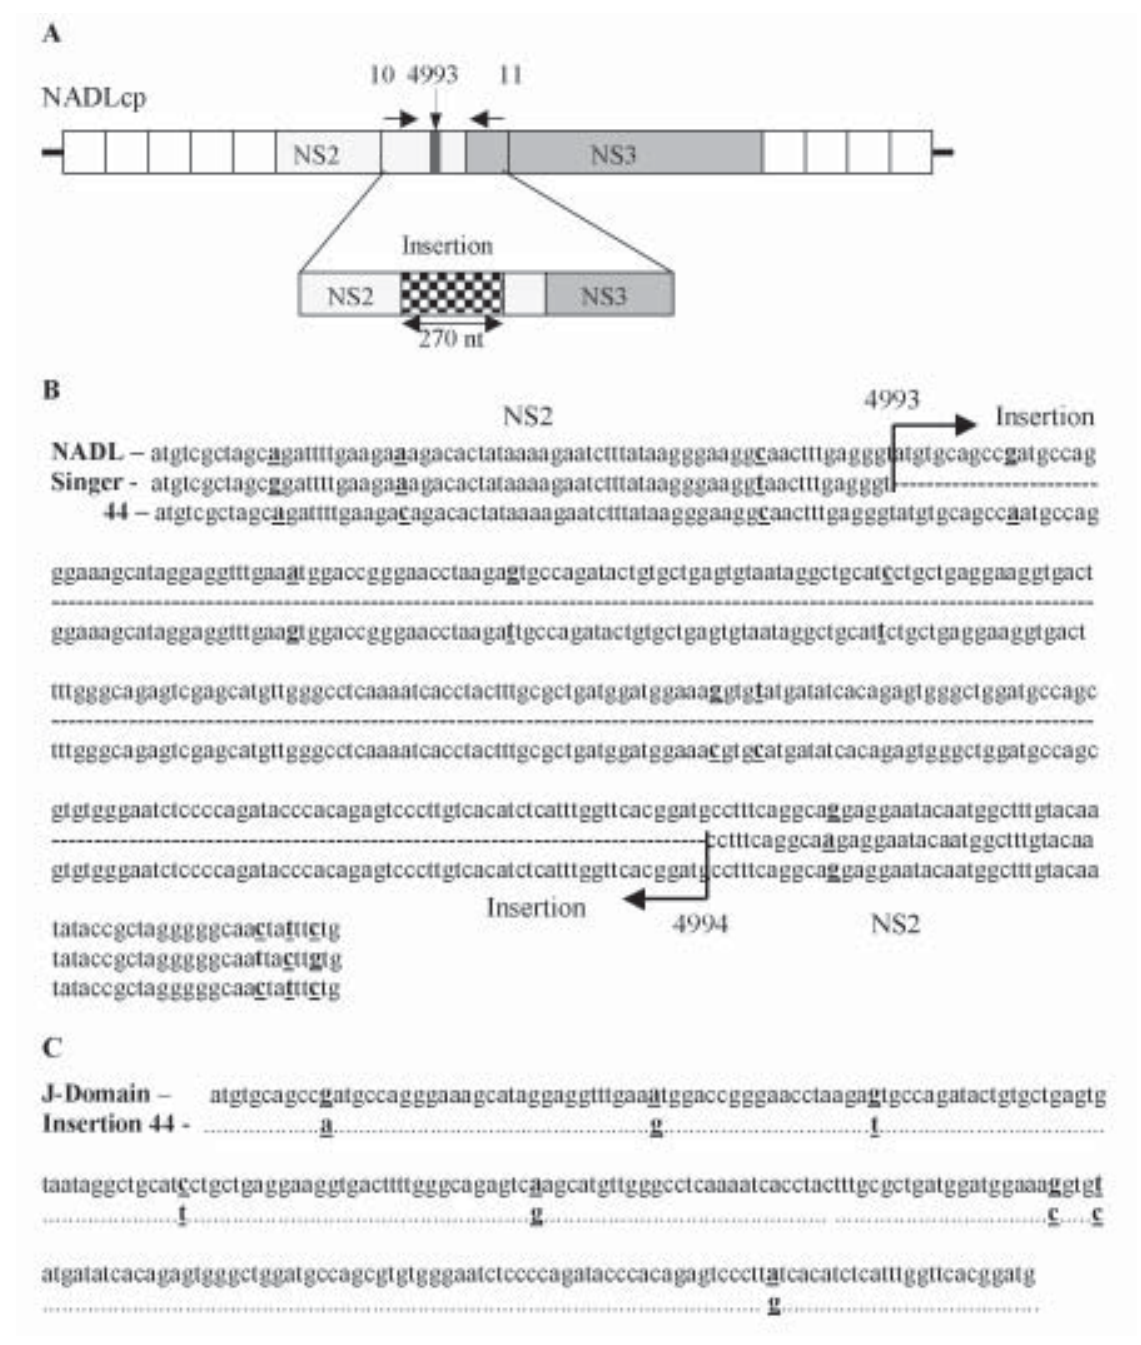
Figure 4. Sequence alignment of the amplicons obtained with primers 10 and 11 of bovine viral diarrhea virus (BVDV) isolates NADL, Singer, and 44 in the NS2-3 region. The number identifies the published NADL sequence. A , Diagram of the genome of BVDV NADL strain showing the location of the insert within the NS2-3 gene. B , Alignment of sequences of NADL, Singer and isolate 44 in the region corresponding to the insert. C , Alignment of sequences of insertion of isolate 44 and the cellular J- Domain protein. The difference in sequences is given in bold and underlined. cp = cytopathic; nt =